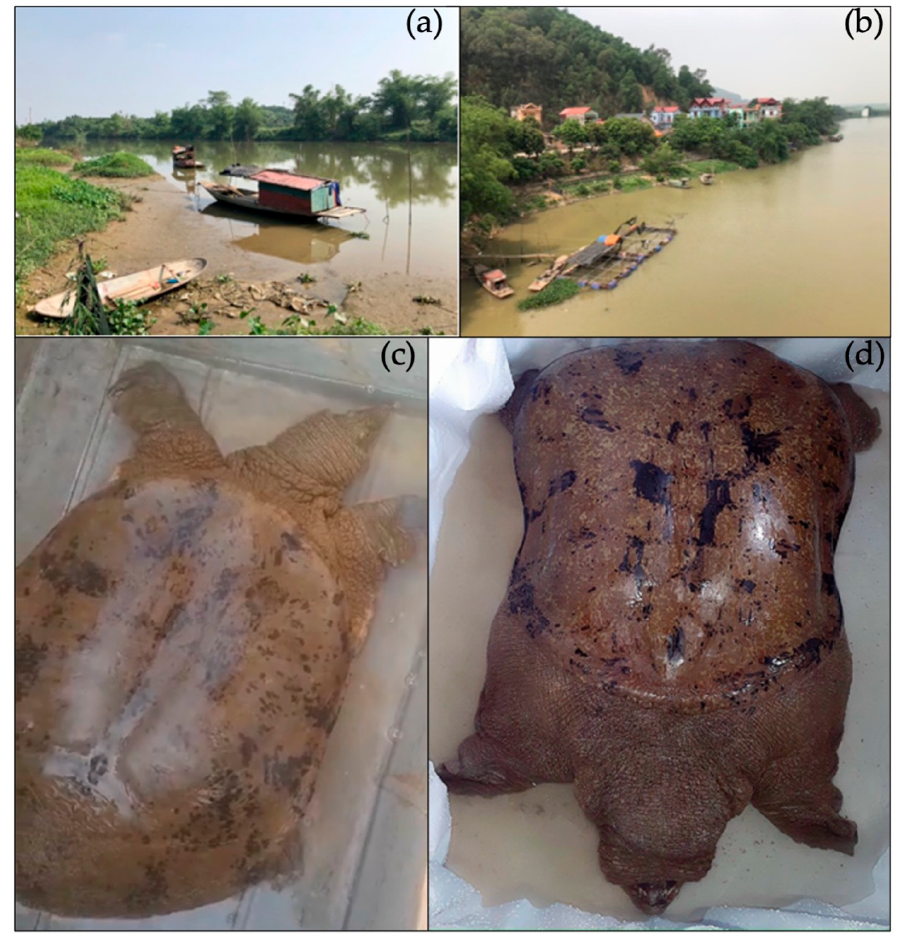
Figure 4. Turtle diversity in Bac Giang, Hai Duong, Thai Binh, and Hung Yen provinces: ( a ) typical